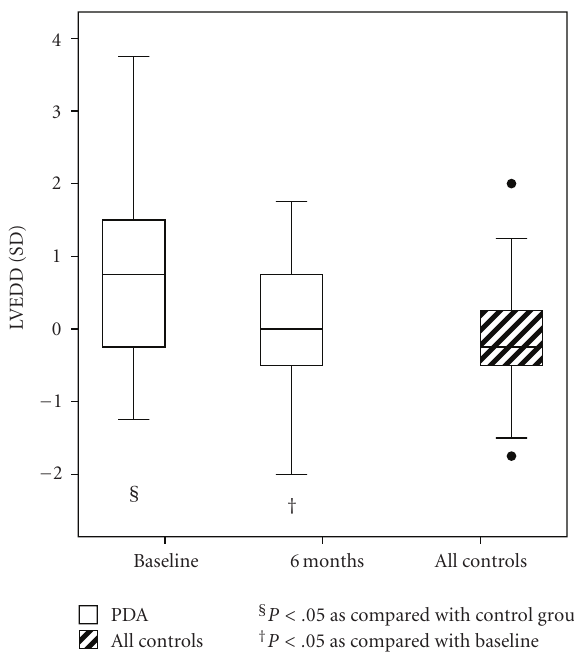
Figure 2: The z -score (SD) of end-diastolic diameter of right ventricle (RVEDD) in patients with atrial septal defect (ASD) and in controls. Whiskers at the top and bottom of each box indicate maximum and minimum; the top and bottom of each box the third and first quartiles; line through the box the median. Solid circles are outliers.